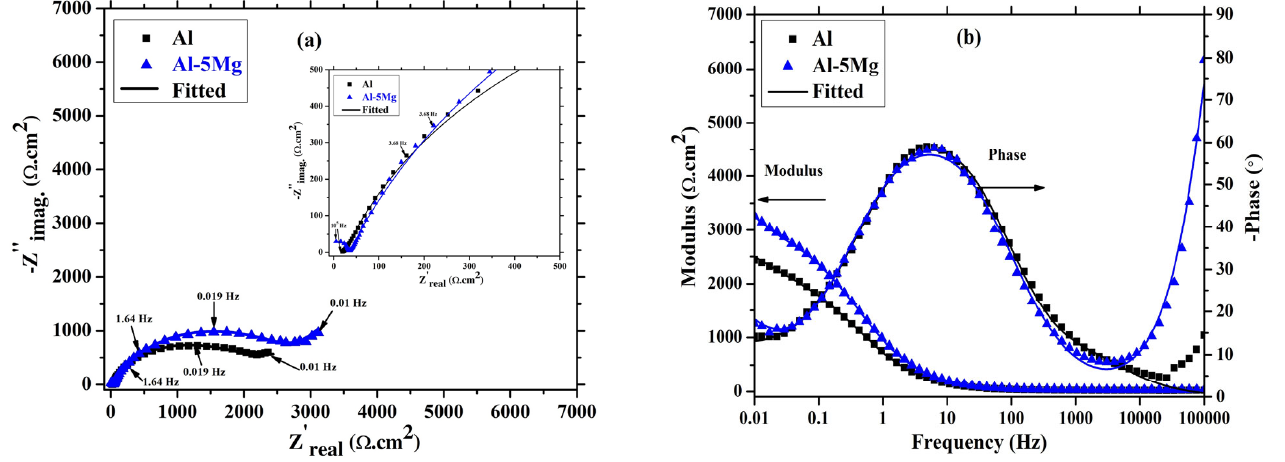
Figure 7. EIS ( a ) Nyquist and ( b ) Bode plots of coatings after 1 h of immersion in 3.5 wt.% NaCl solution.